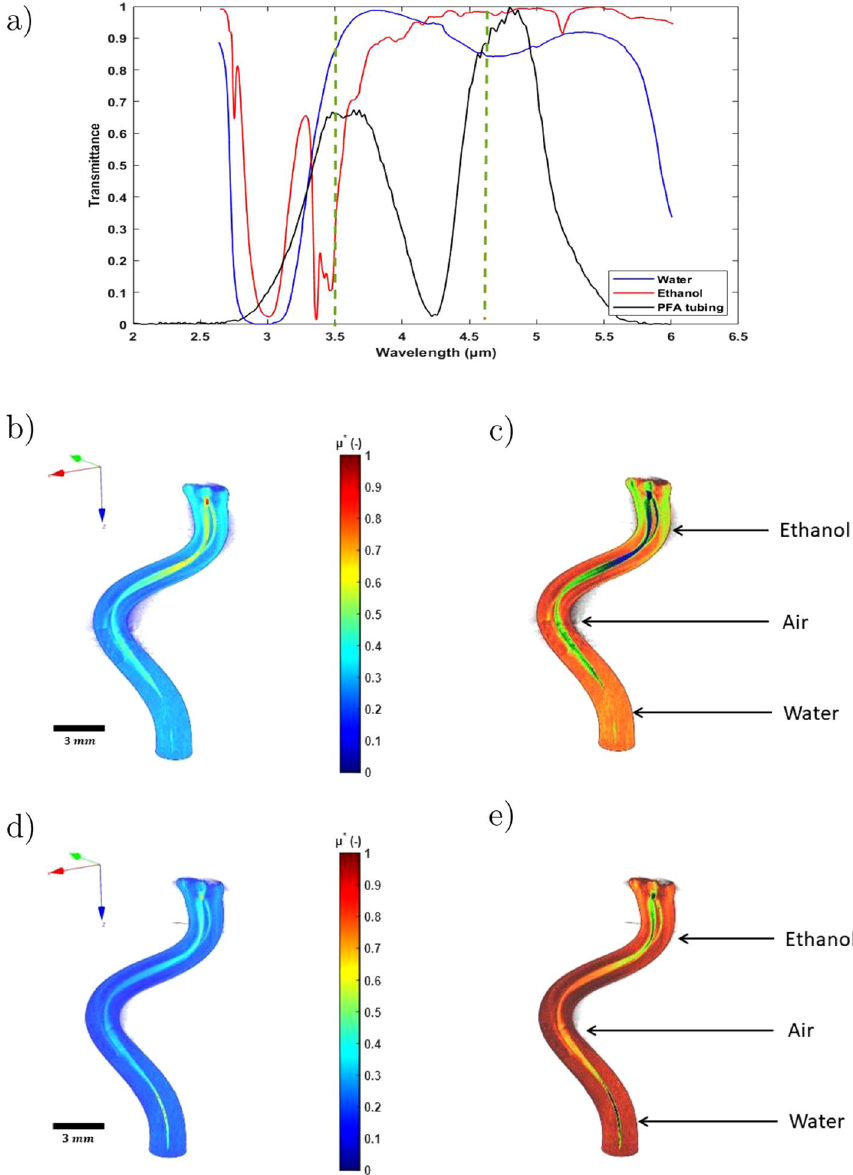
Figure 8. ( a ) Transmittance of water, ethanol and PFA tubing. Dimensionless reconstructed three-dimensional absorptivities maps of the PFA tubing: ( b ) 3D absorptivity map at (cid:31) = 3.5 μm, ( c ) 3D absorptivity map at (cid:31) = 3.5 μm with colored segmentation for each media, ( d ) 3D absorptivity map at (cid:31) = 4.6 μm, ( e ) 3D absorptivity map at (cid:31) = 4.6 μm with colored segmentation for each media. (Created with MATLAB 2020a, https ://mathw